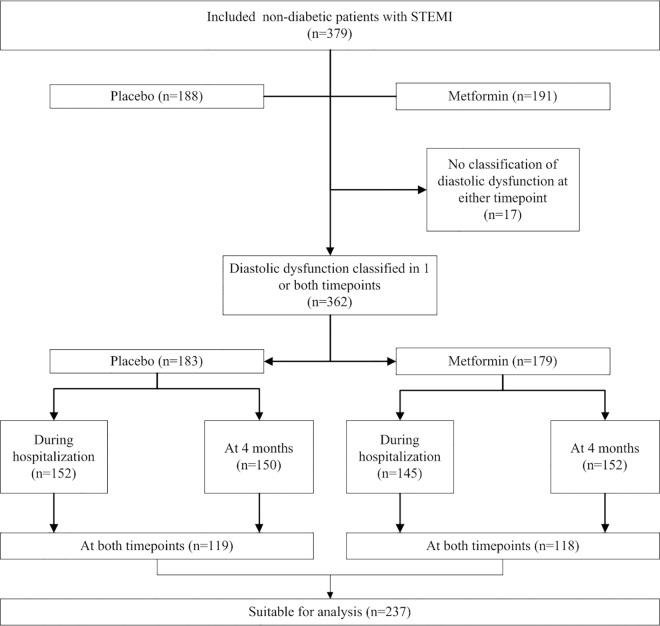
Flowchart of echocardiographic assessment during hospitalization and at 4 months according to randomization.STEMI denotes ST-segment elevation myocardial infarction.